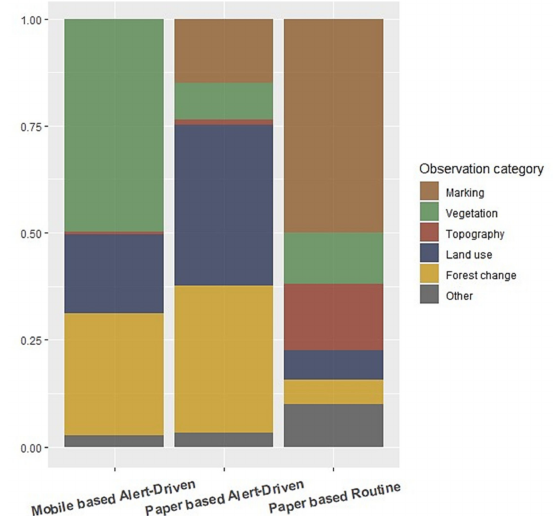
Figure 6. Categories of observations made per monitoring approach (see Table 1 for